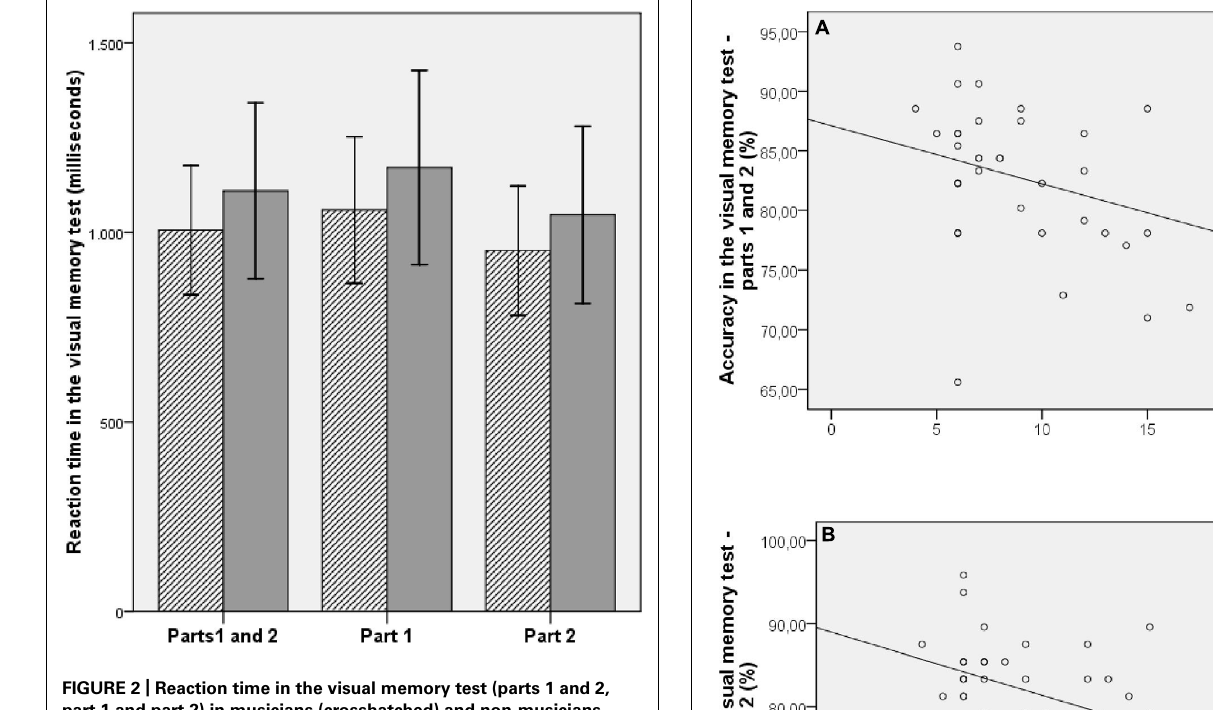
effect of test’s part [ F (1,73) = 3.96; p = 0.050], and no interac-